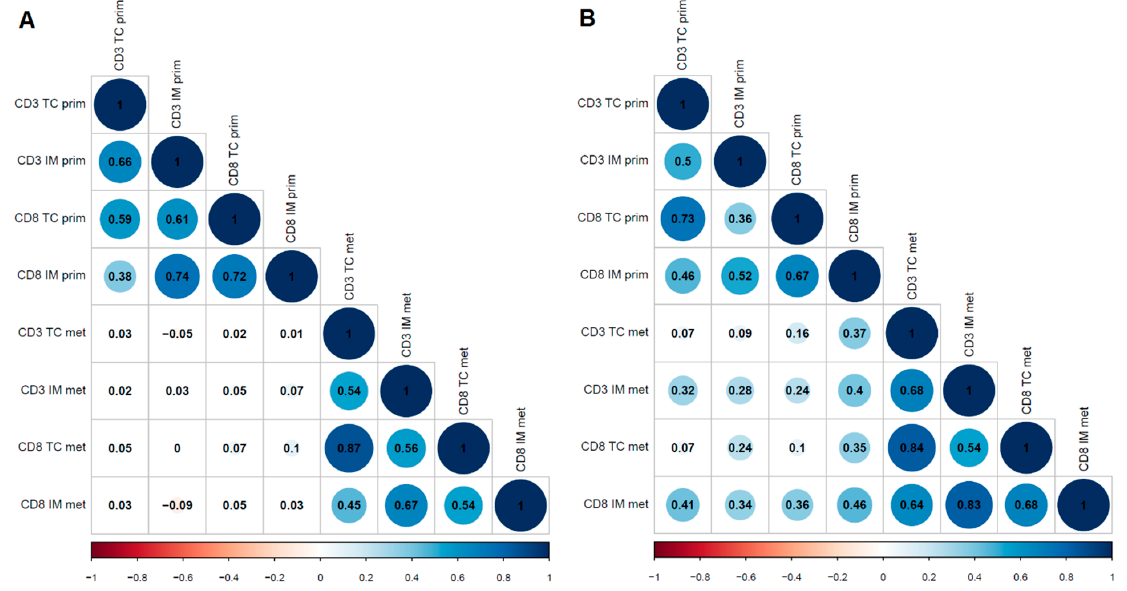
Figure 3. Correlograms of T cell densities in colorectal adenocarcinomas and their metastases (( A ): Liver; ( B ): Lung). The numbers indicate Spearman’s rank correlation coefficients. Abbreviations: IM: invasive margin; prim: primary tumour; met: metastasis; TC: tumour center.